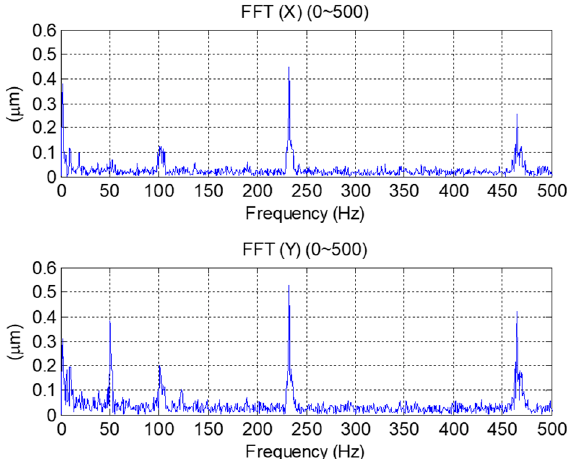
Figure 11. PSD output signals based on AC voltage stabilizer.